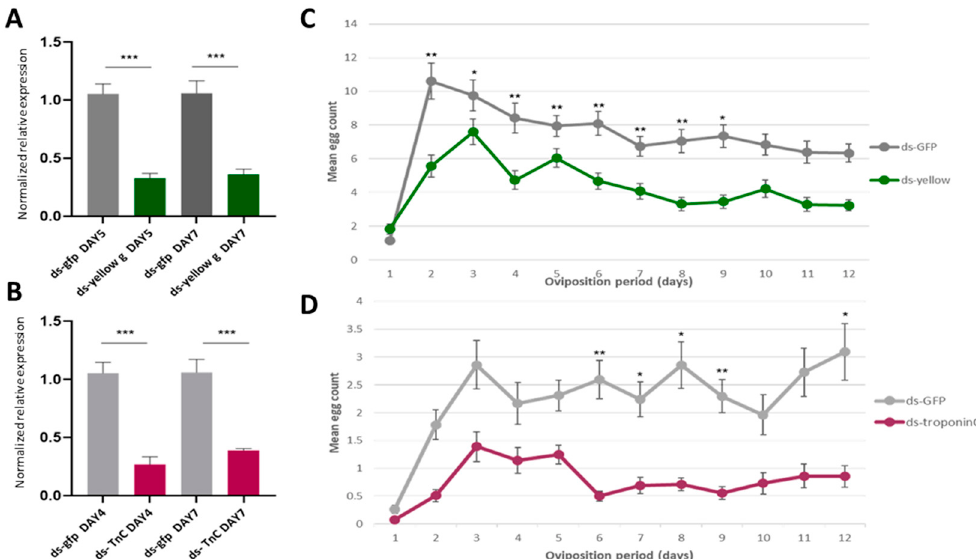
Figure 6. The effect of yellow-g and troponin C knockdown to oviposition. ( A , B ) Relative quantitative analysis of the yellow-g gene ( A ) and the troponin C gene ( B ) in the double-stranded (ds)RNA-injected B. oleae insects. Expression levels were evaluated relative to the control injections with ds- gfp . All values were normalized using Rpl19 and actin3 as the reference genes. Data are presented as means ± standard deviation (SD). Asterisks indicate the significance level of the difference between the two samples ( p < 0.05, unpaired Student’s t -test). ( C , D ) Oviposition activity of treated females during a 12-day period. Day count starts one day after mating assay. Mean values ± standard error of triplicate data from three biological replicates is shown. ( C ) The mean daily egg count for the females mated with males injected with ds- yellow (green line) and males injected with ds- gfp (grey line). ( D ) The burgundy line shows the oviposition rate of the females injected with ds- troponin C and the grey line shows the oviposition of the control group (ds- gfp ). The asterisks indicate statistically significant difference: p value < 0.05 (*), p < 0.021 (**), p < 0.0002 (***) (one-way ANOVA followed by Dunnett’s multiple comparisons